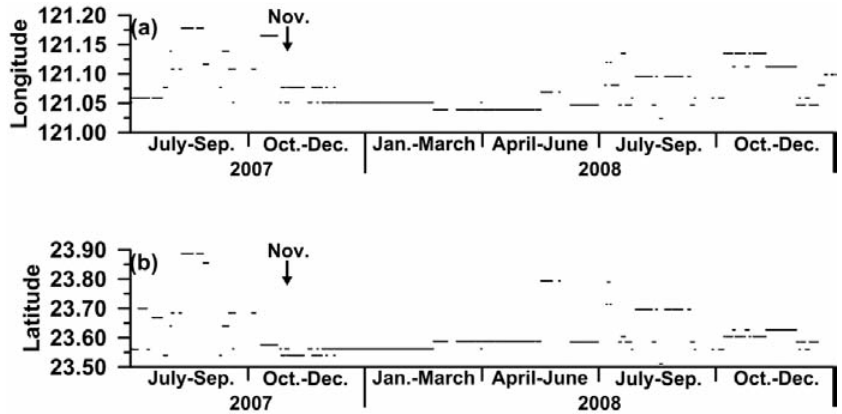
Figure 2. Variations in the midpoint computed by the stations from July 2007 to December 2008, according to longitude (a) (˚E) and latitude (b) (˚N).